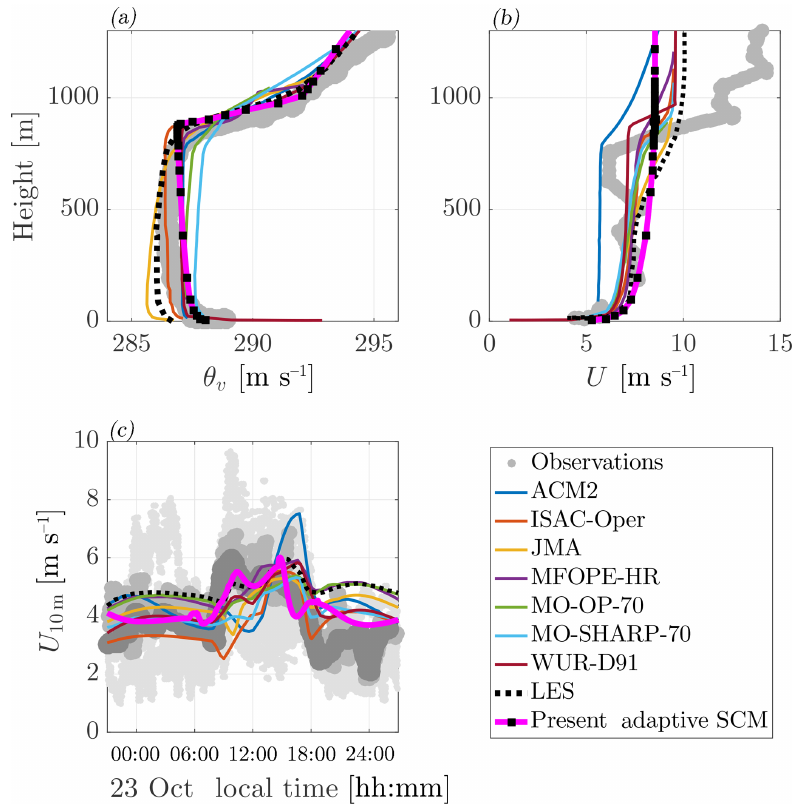
Figure 6. Comparison of the results obtained with the adaptive-grid SCM and the participating models in the work of Svensson et al. (2011) for the vertical profiles of (a) the virtual potential temperature and (b) the wind-speed magnitude, for 14:00 local time on 23 October. Panel (c) the evolution of the 10m wind speed ( U 10m ) on 23 October. For the model abbreviations used in the legend, see Svensson et al. (2011). The different shades of grey in plot (c) indicate observations from different measurement devices; see Svensson et al. (2011) for the details.